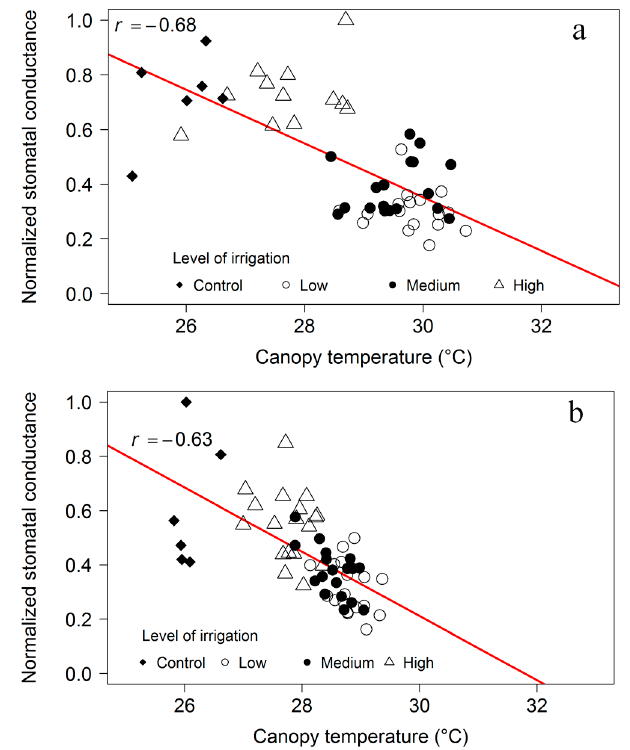
Figure 11. Correlation between canopy temperature and normalized stomatal conductance at ( a ) 80 and ( b ) 44 DBH.